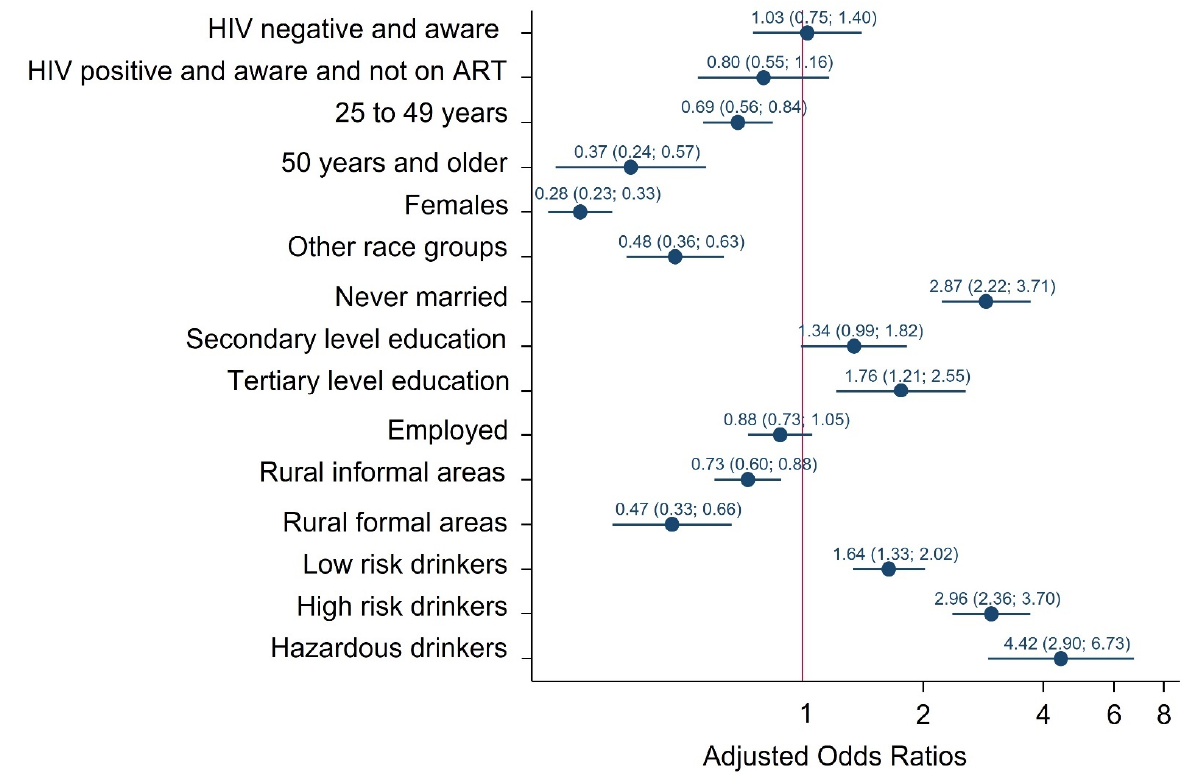
Figure 1. Multivariate logistic model of factors associated with reporting multiple sexual partners in the past year among individuals 15 years older, South Africa 2017 survey.